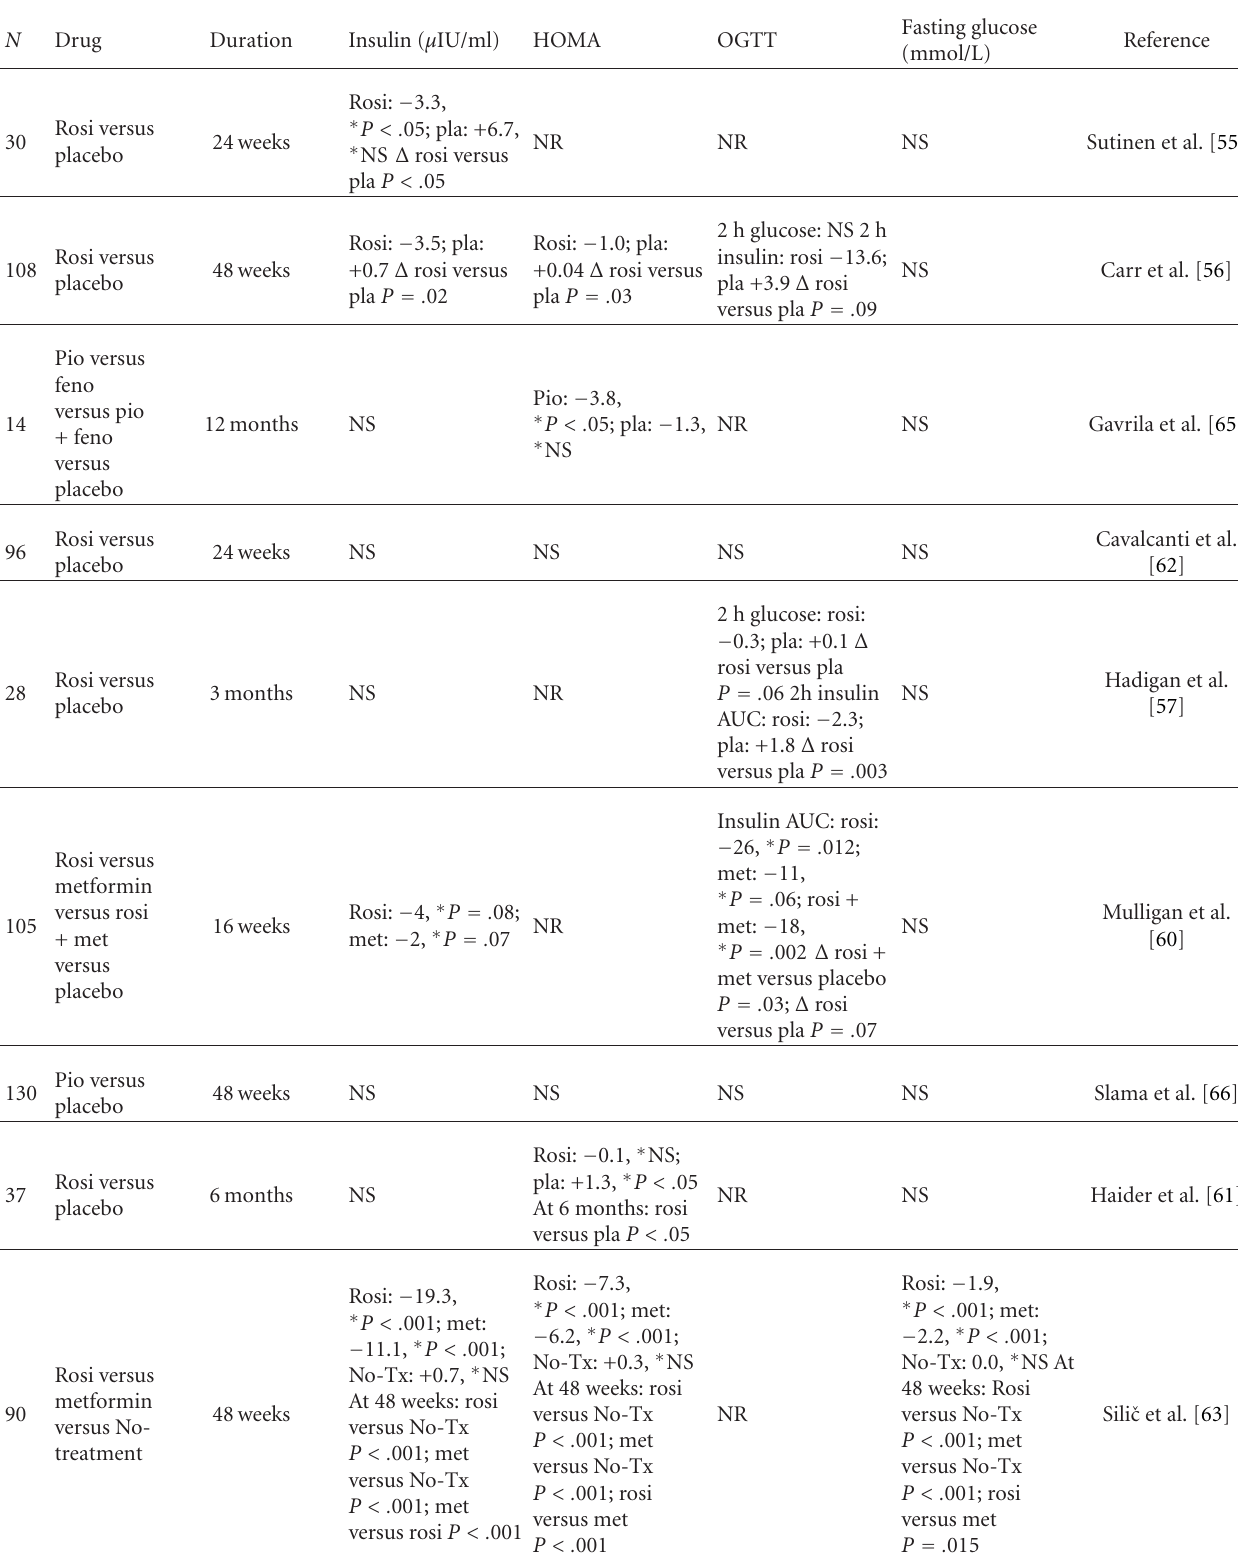
Table 4: The e ff ects of thiazolidinediones on glycemic indeces in controlled trials with HIV infected, HAART-treated patients. HAART = highly active antiretroviral therapy, HOMA = homeostasis model assessment (fasting insulin [ μ IU/ml] × fasting glucose